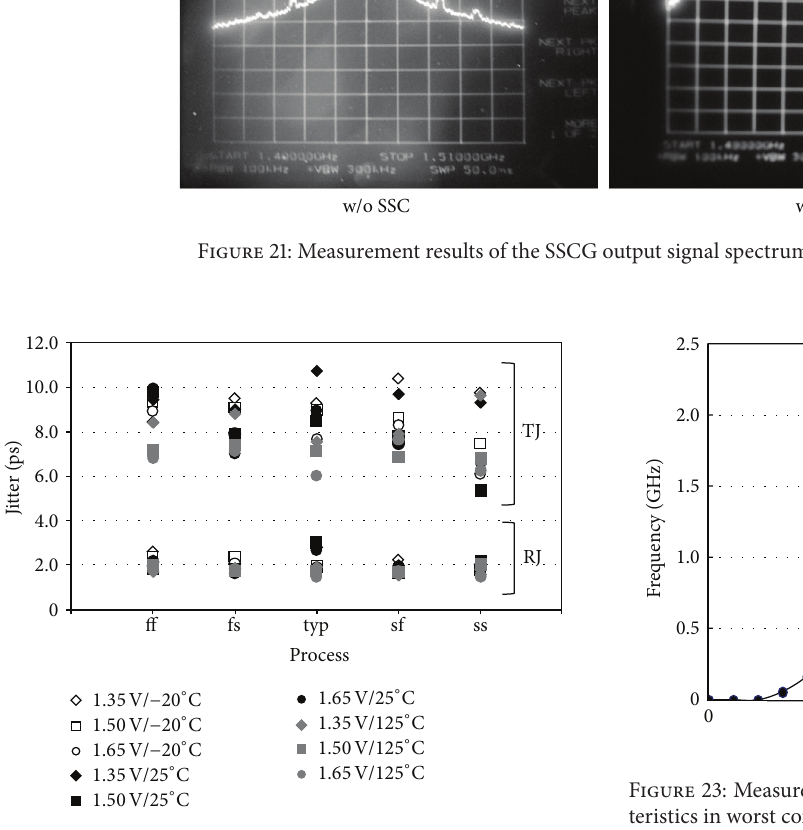
Figure 22: Measurement result of output signal jitter of RJ and TJ.